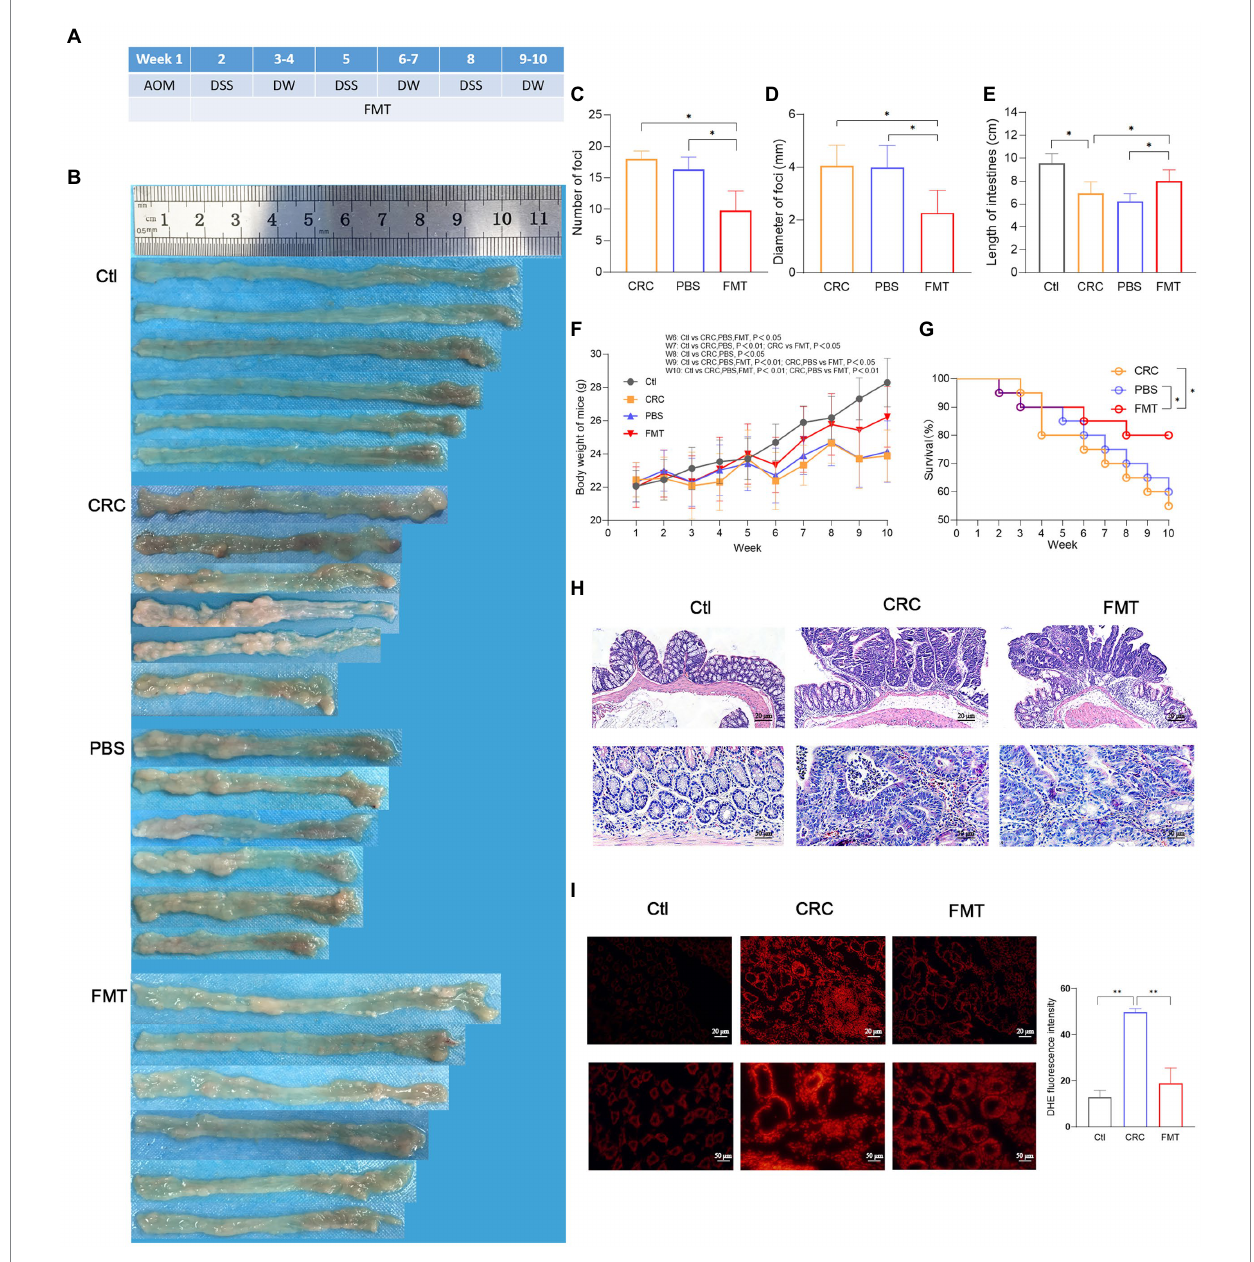
FIGURE 1 Suppressive effect of FMT on CRC progression. (A) Timeline of experimental procedure. (B) Pictures of intestinal tissue from each experimental group, including normal control mice (Ctl), mouse model of colorectal cancer (CRC), CRC mice treatment with PBS as negative control (PBS), and CRC mice receiving fecal microbiota transplantation (FMT). (C–E) The average number, diameter of cancerous foci and the length of intestinal tissues in each group. * p < 0.05 (Ctl, n = 20; CRC, n = 11; PBS, n = 12; FMT, n = 16). (F,G) The average body weight and survival rate of mice in each week. * p < 0.05 (Ctl, n = 20; CRC, n = 11; PBS, n = 12; FMT, n = 16). (H) HE staining of intestinal tissue. (I) Production of superoxide in the intestine indicated by the intensity of red fluorescence. ** p < 0.01, n =